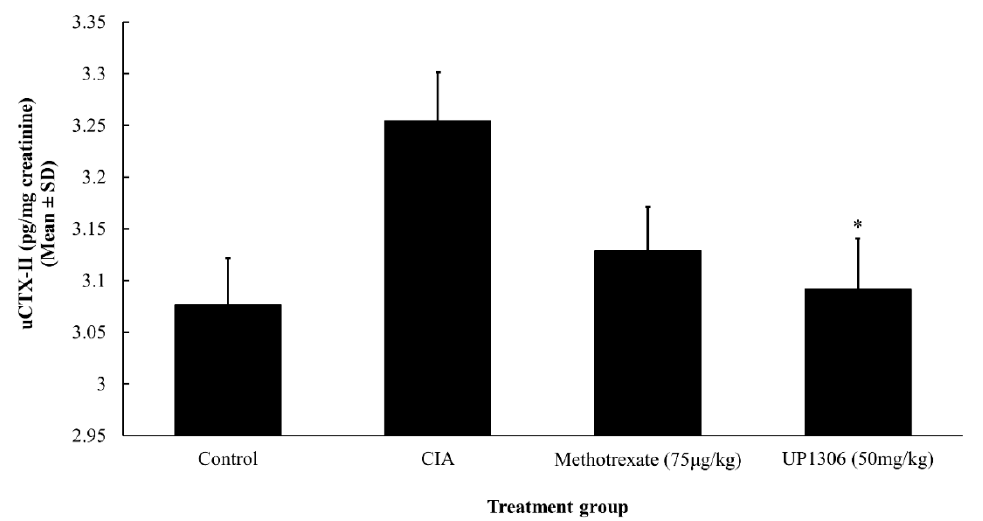
Mean ± log10SD. log10SD.